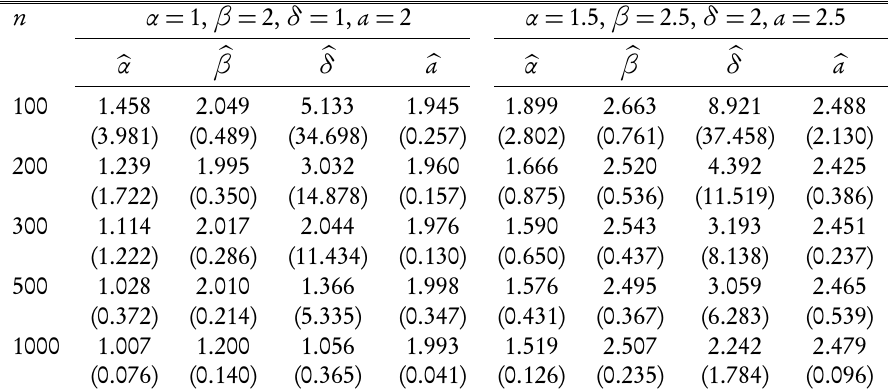
Empirical means and the RMSEs of the MOG-W